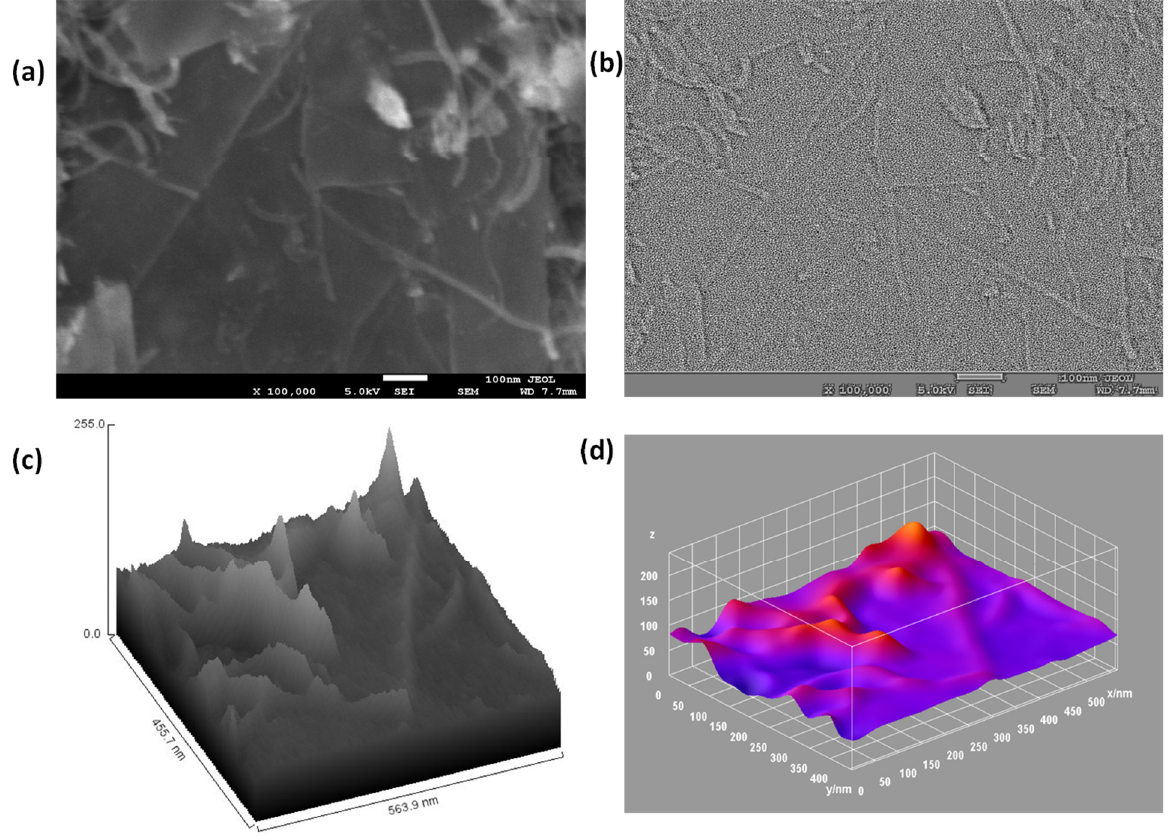
Figure 5. ( a ) SEM image of the MWCNT/GO nanohybrid, ( b ) Shape index plot from the SEM image of the MWCNT/GO nanohybrid, ( c ) Hill stack plot from the SEM image of the MWCNT/GO nanohybrid, ( d ) 3D surface plot from the SEM image of the MWCNT/GO nanohybrid. Furthermore, the hill stack plot from the SEM image of the MWCNT/GO nanohybrid depicts the distribution of MWCNTs over the GO plane, thereby providing a high degree of surface roughness, which increases its super-capacitive properties (Figure 5c). This can also be seen from the 3D surface image (Figure 5d), where MWCNTs are visible in the crest form with the color of a higher wavelength, while the GO sheets are visible in the trough form with the color of a lower wavelength. Both the MWCNTs and the GO sheet thus developed a favorable network to provide high capacitive properties.